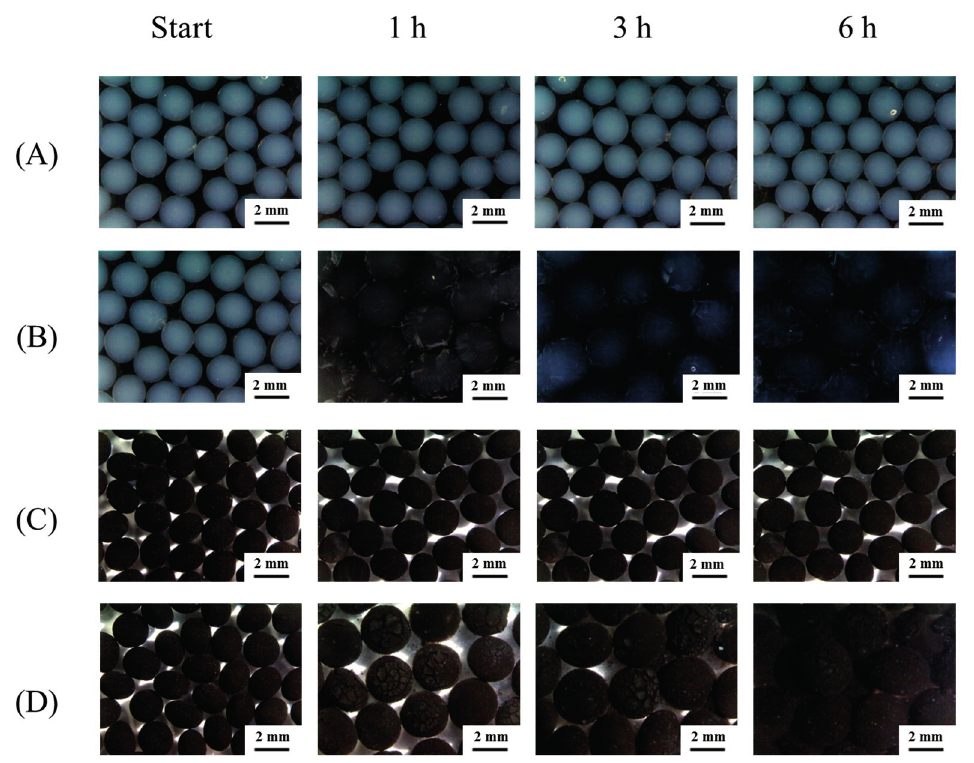
Figure 4. The degradation of alginate beads in various pH environments.